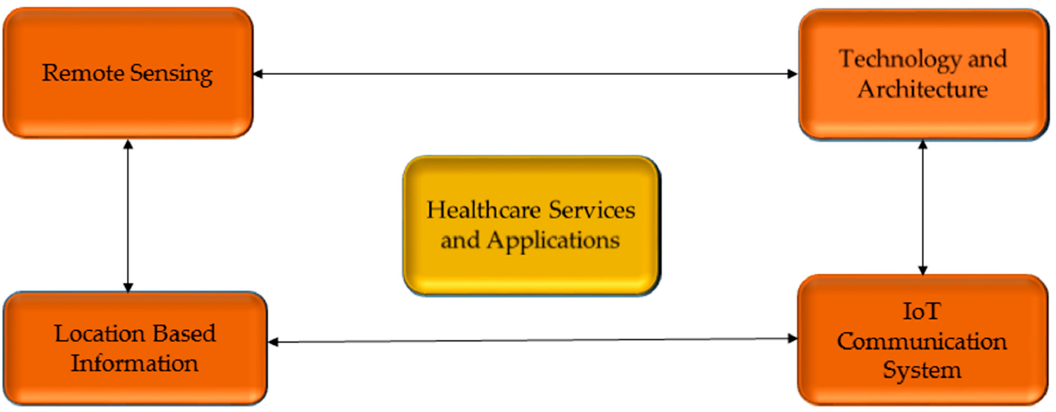
Figure 2. The IoT risk management model in healthcare [23].